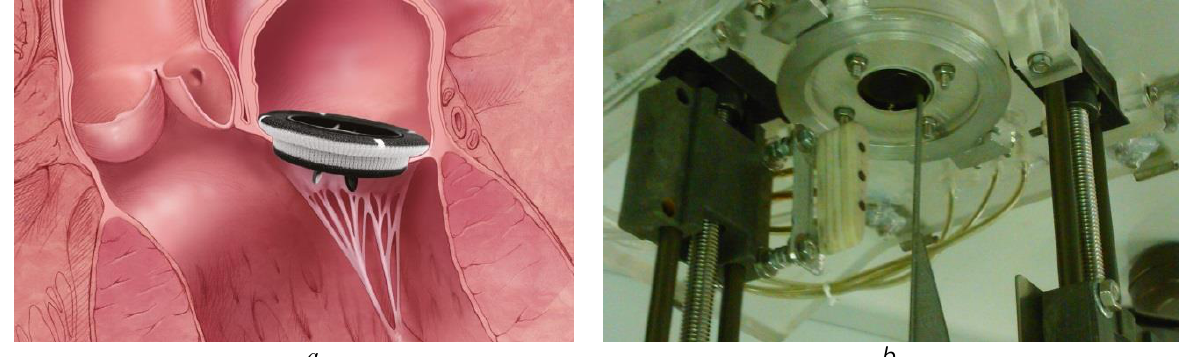
Figure 1. Bileaflet mechanical heart valve inside the left venticle (a) and the experimental bench